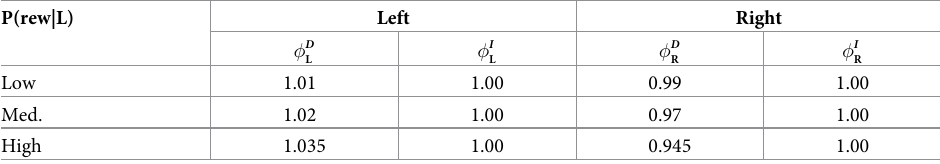
Table 4. Corticostriatal weights in the CBGT network across levels of reward probability. In each reward condition (rows), corresponding values of ϕ were used to scale the synaptic efficacy of corticostriatal inputs ( g Ctx-MSN ) to the direct ( D ) and indirect ( I ) pathways within the left ( L ) and right ( R ) action channels. P(rew|L)